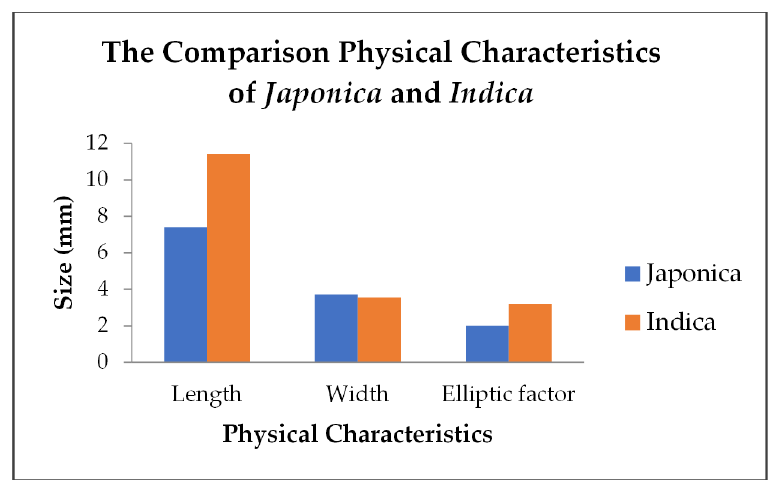
Figure 1. The comparison physical characteristics of japonica and indica.